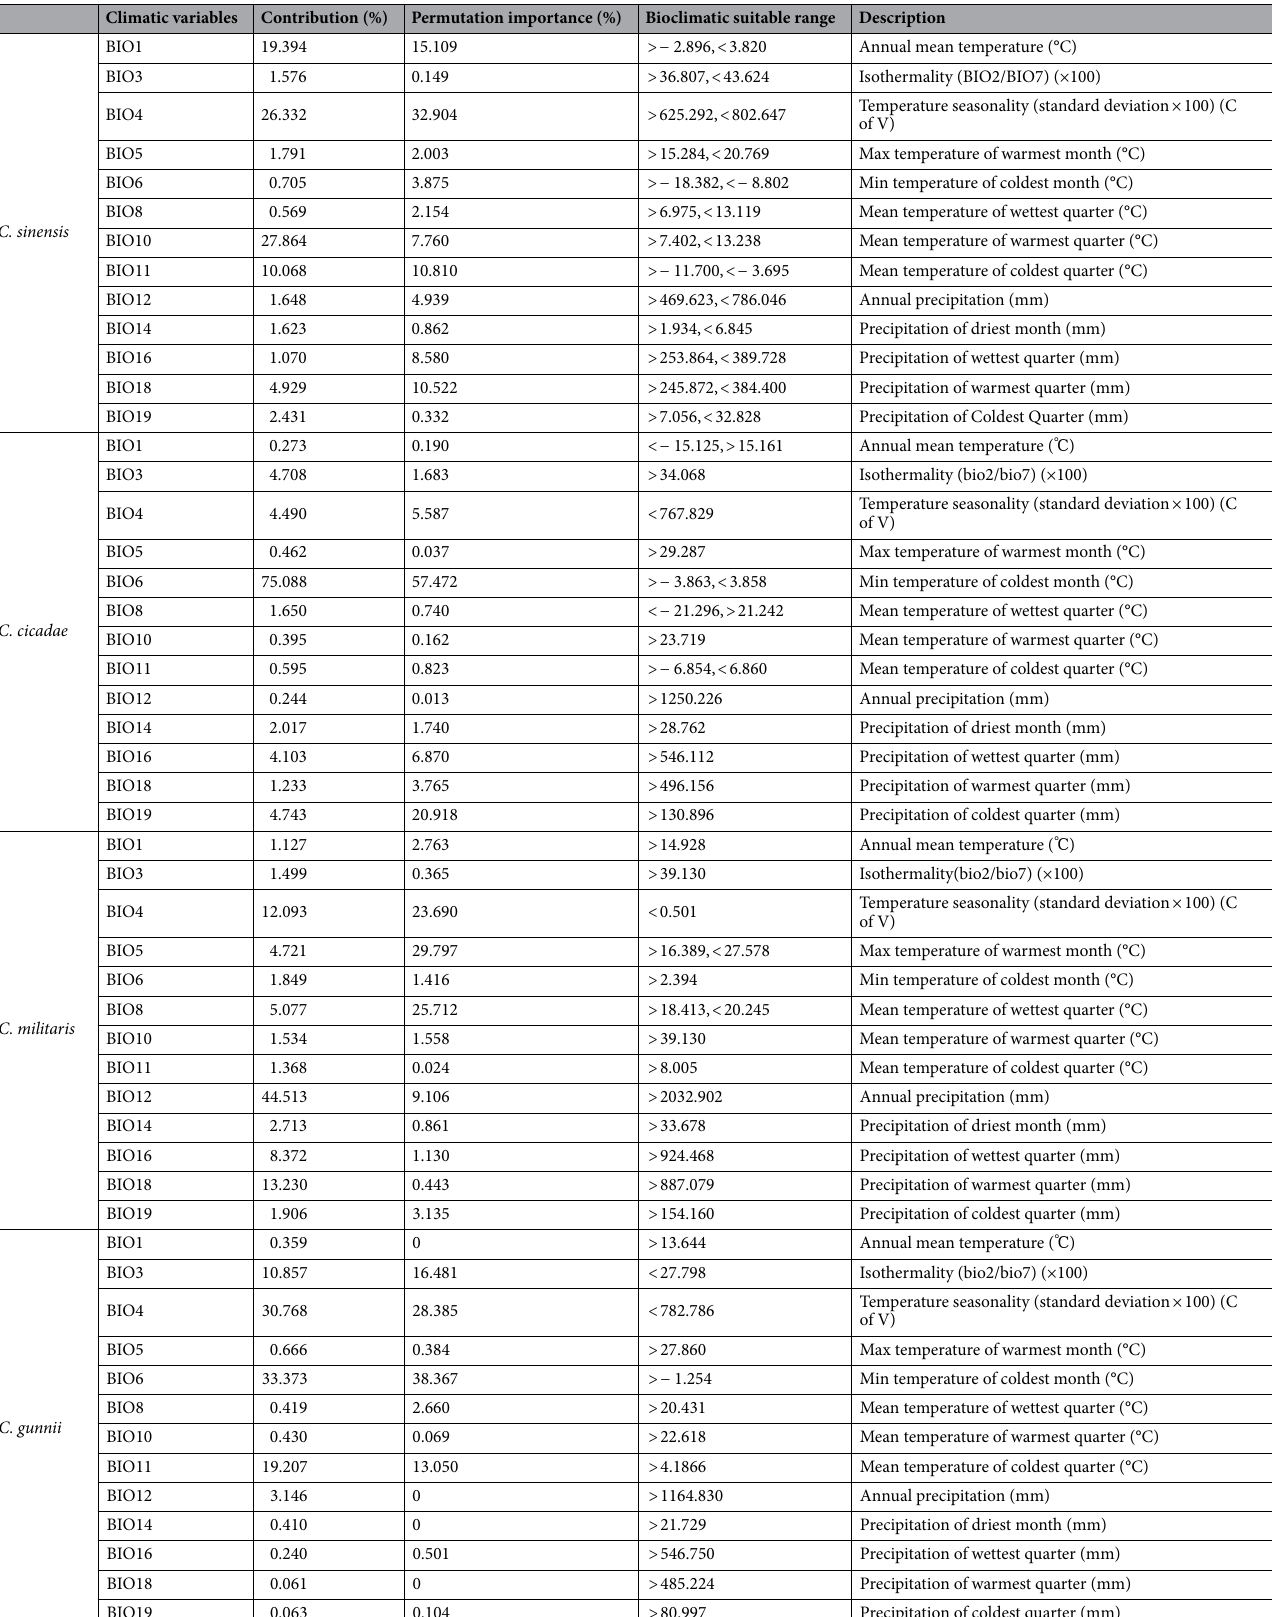
Table 2. Ecological climatic variables and niche model contribution of C.sinensis, C.cicadae, C.militaris and